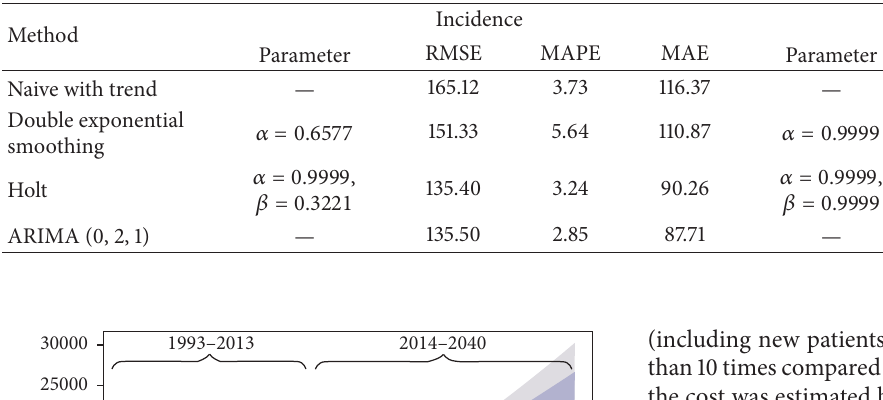
Table 1: Comparison of forecast error from number of ESRD patients, 1993–2013.